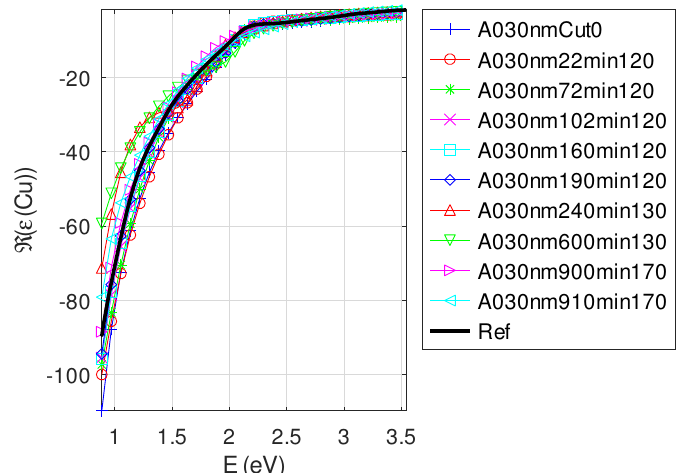
Figure A6. Real part of the relative permittivity of copper as a function of the photon energy: bulk (black) and best calculated (color) for each oxidized sample (initial thickness h 0